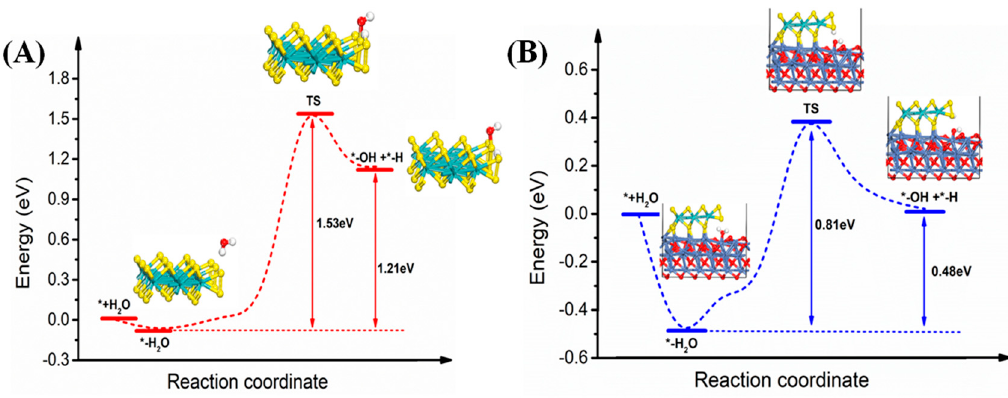
Figure 6. Energy pathway for water dissociation at the MoS 2 zigzag edge ( A ) and the MoS 2 /NiO (111) interface ( B ) with atomic configurations of initial state (water adsorption), transition state (TS) and final state (water dissociation). The reaction energy and the activation barrier are indicated in the inset.